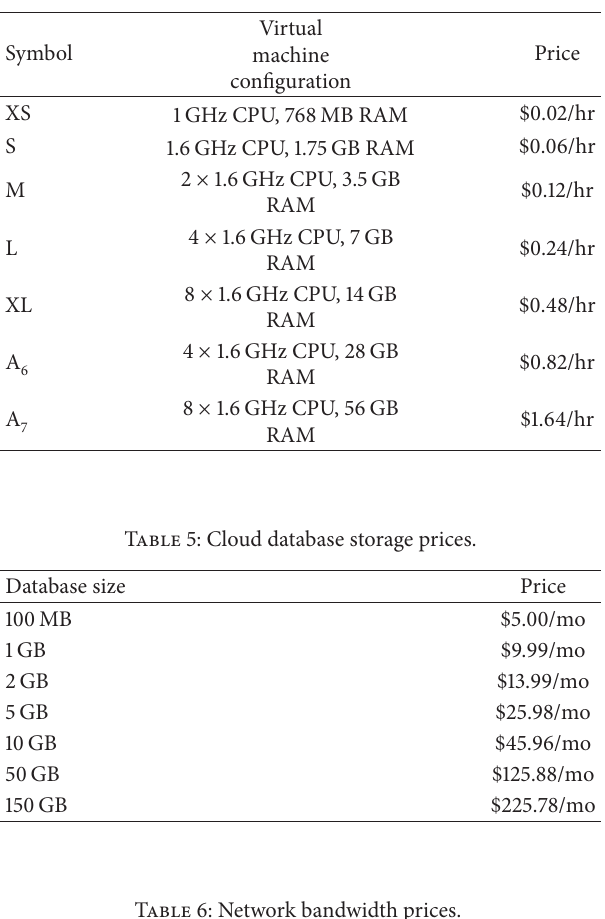
Table 4: Virtual machine prices.